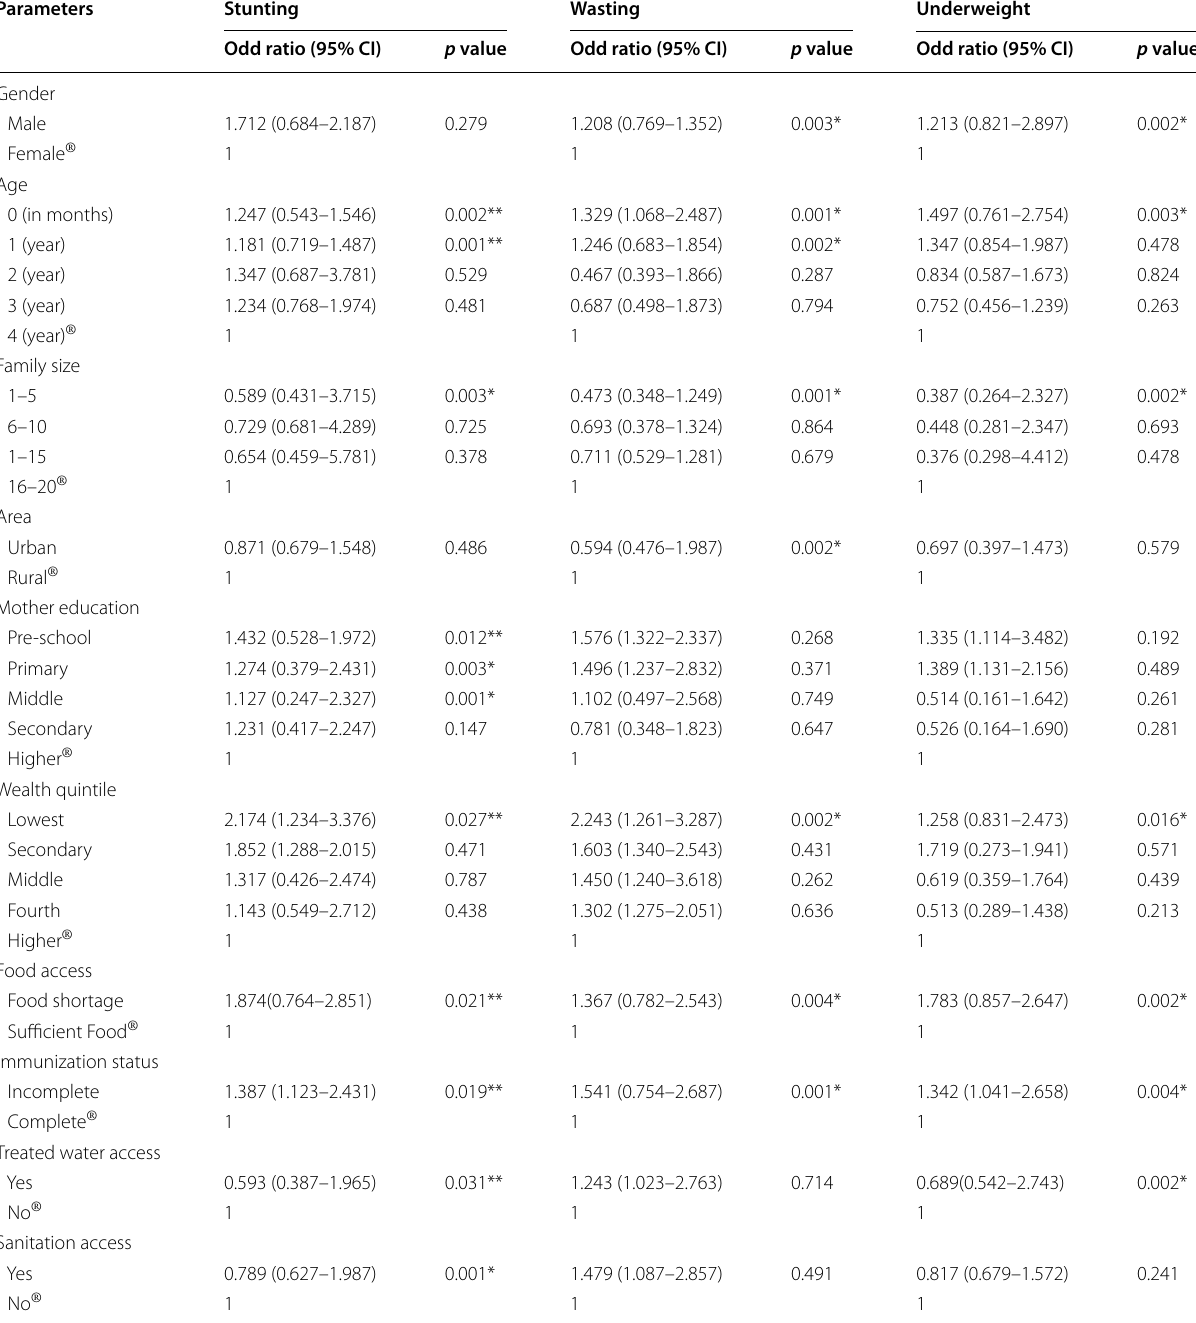
Table 2 Parameters estimates of logistic regression model and factors affecting stunting, wasting and